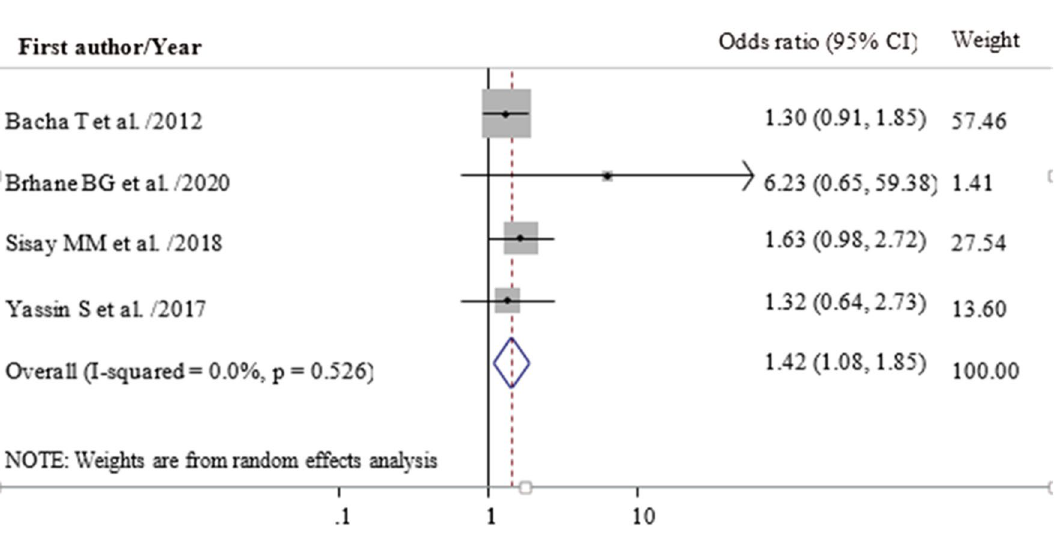
Figure 5. Forest plot of adjusted odds ratio showing the association between being female children and ART failure among children in Ethiopia,